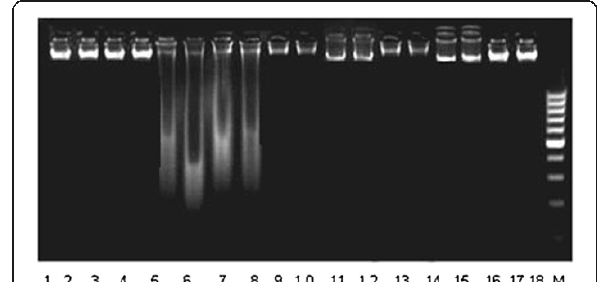
Figure 2 Agarose gel showing DNA damage by CCl 4 and preventive effect of Launaea procumbens extracts in different groups. Lanes (from left), Control (1 – 4), CCl 4 (5 – 8), 100 mg/kg LME (9, 12) 200 mg/kg LME (13, 16), 50 mg/kg RT (17, 18), DNA marker (M).